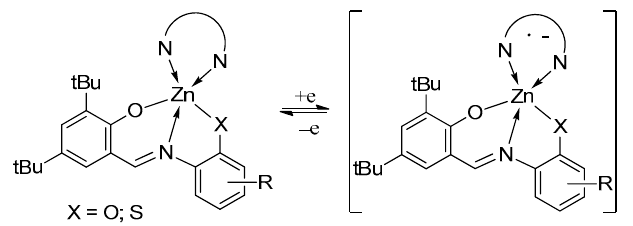
Scheme 5. The electrochemical formation of monoanionic